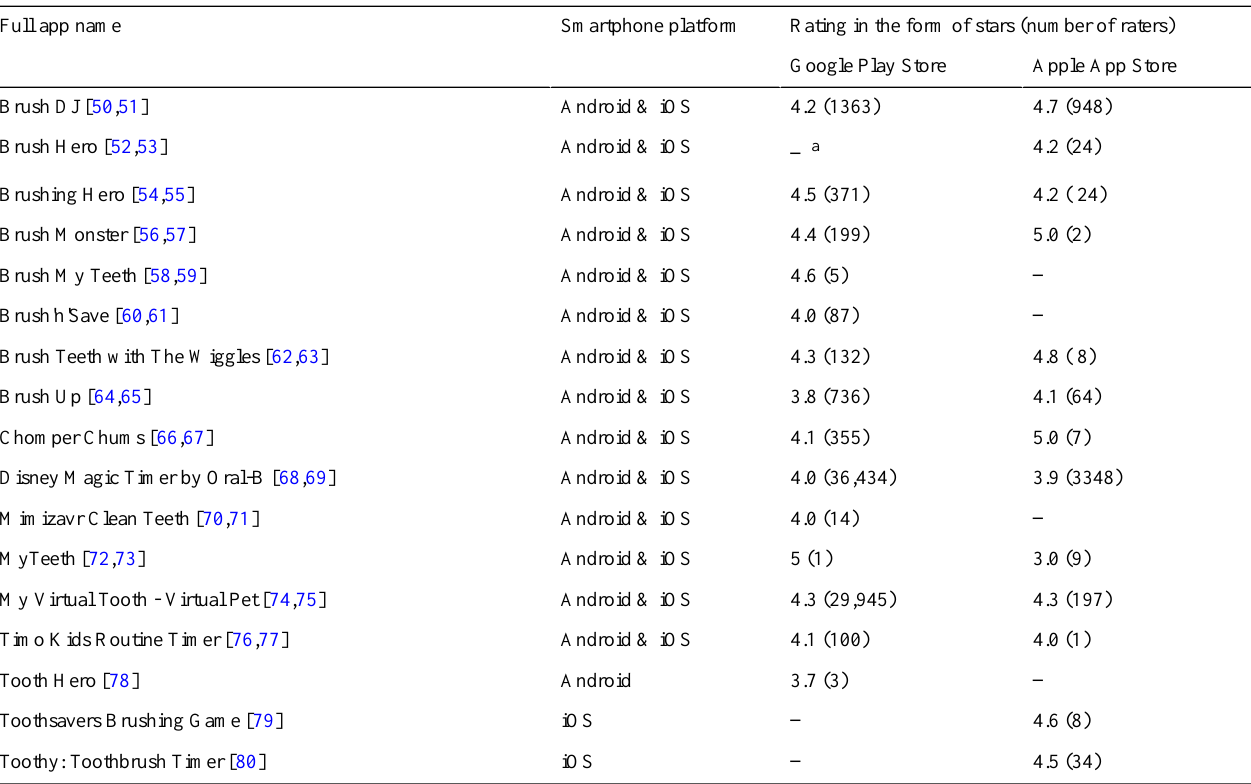
Table 1. Description of the included